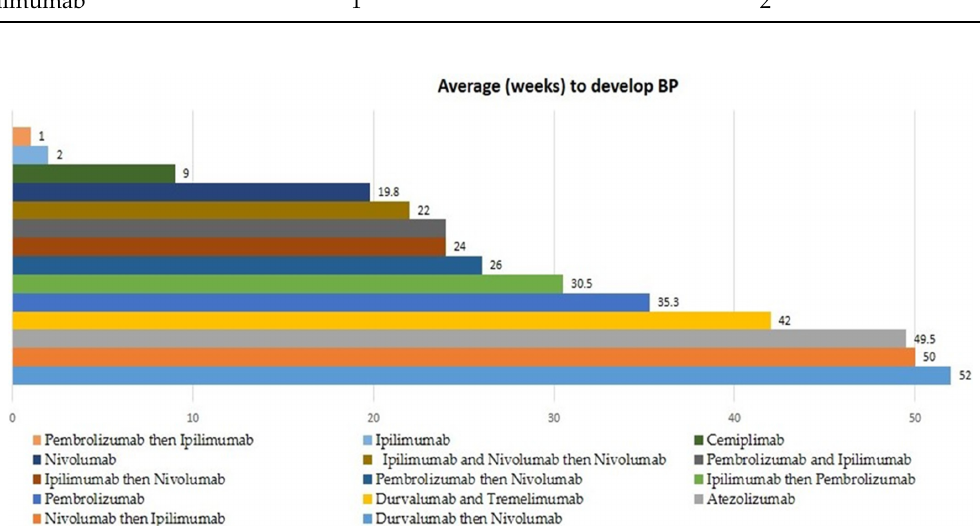
Figure 2. Median weeks until presentation of Bullous Pemphigoid adverse event by treatment